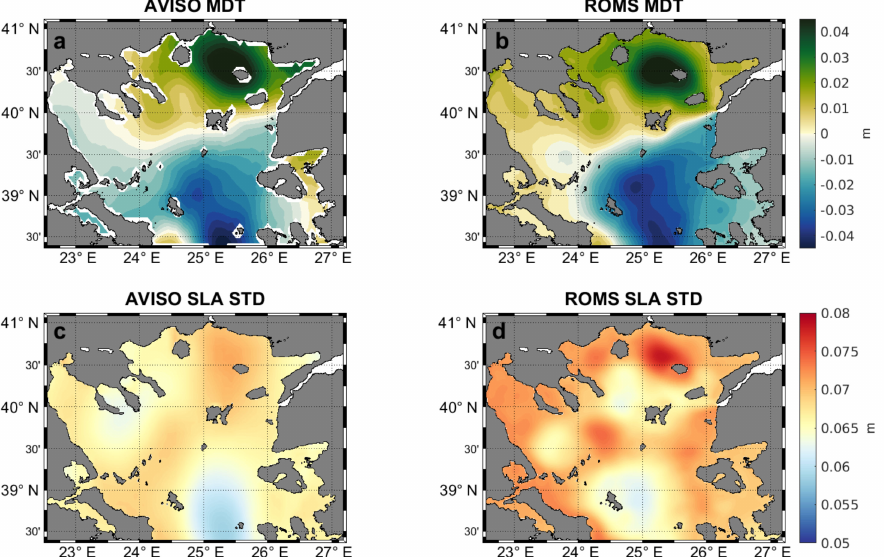
Figure 7. North Aegean Sea Mean Dynamic Topography (MDT) from satellite data ( a ), model results ( b ), and standard deviation of Sea Level Anomaly (satellite ( c ) and model ( d